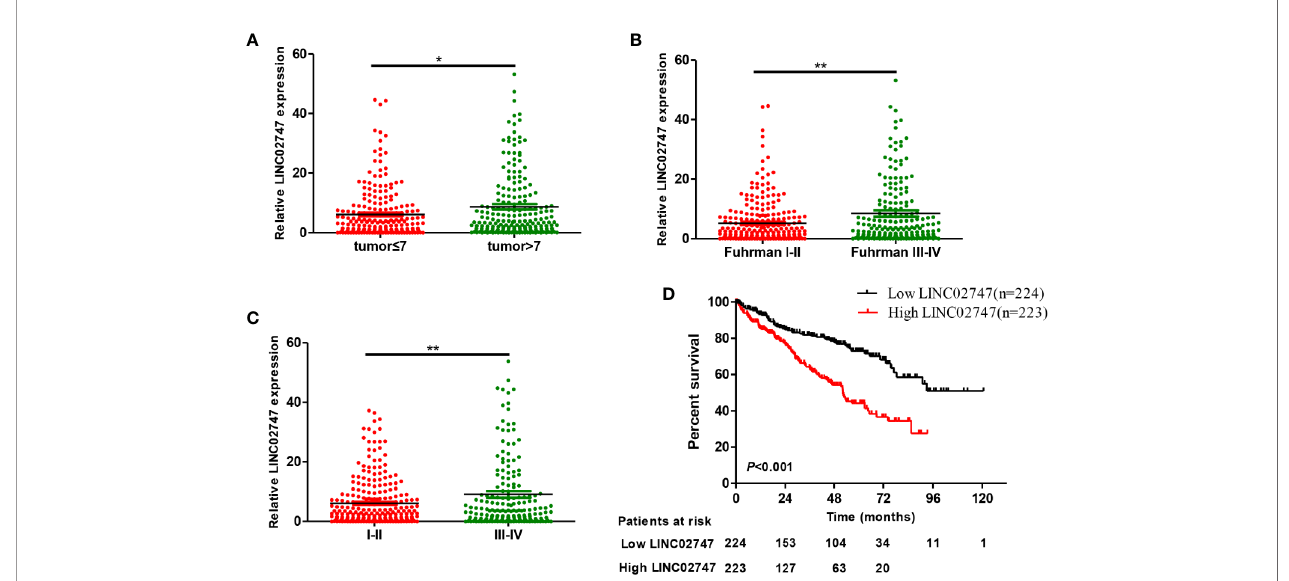
FIGURE 2 | (A) The expression of LINC02747 in different tumor sizes based on TCGA dataset. (B) The expression of LINC02747 in different Fuhrman grades based on TCGA dataset. (C) The expression of LINC02747 in different TNM stages based on TCGA dataset. (D) The overall survival (OS) of patients with high LINC02747 expression was signi fi cantly less than that of patients with low LINC02747 expression. (*** P < 0.001, ** P < 0.01, * P <